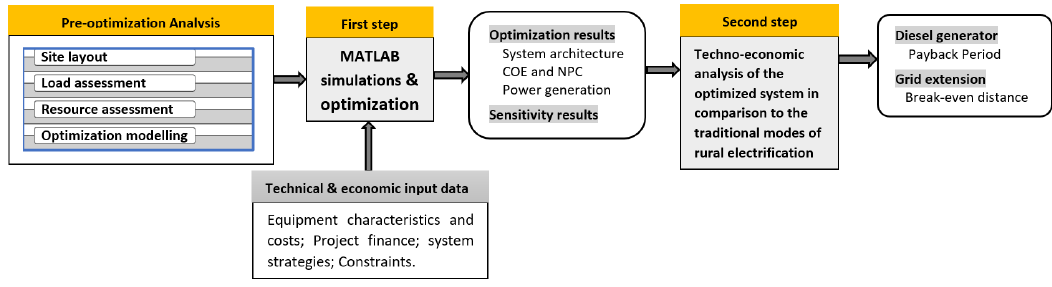
Figure 2. Block diagram of research methodology.